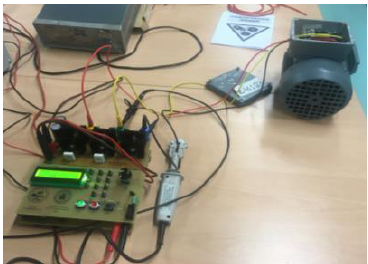
Fig. 1. The hardware setup of the constructed inverter.